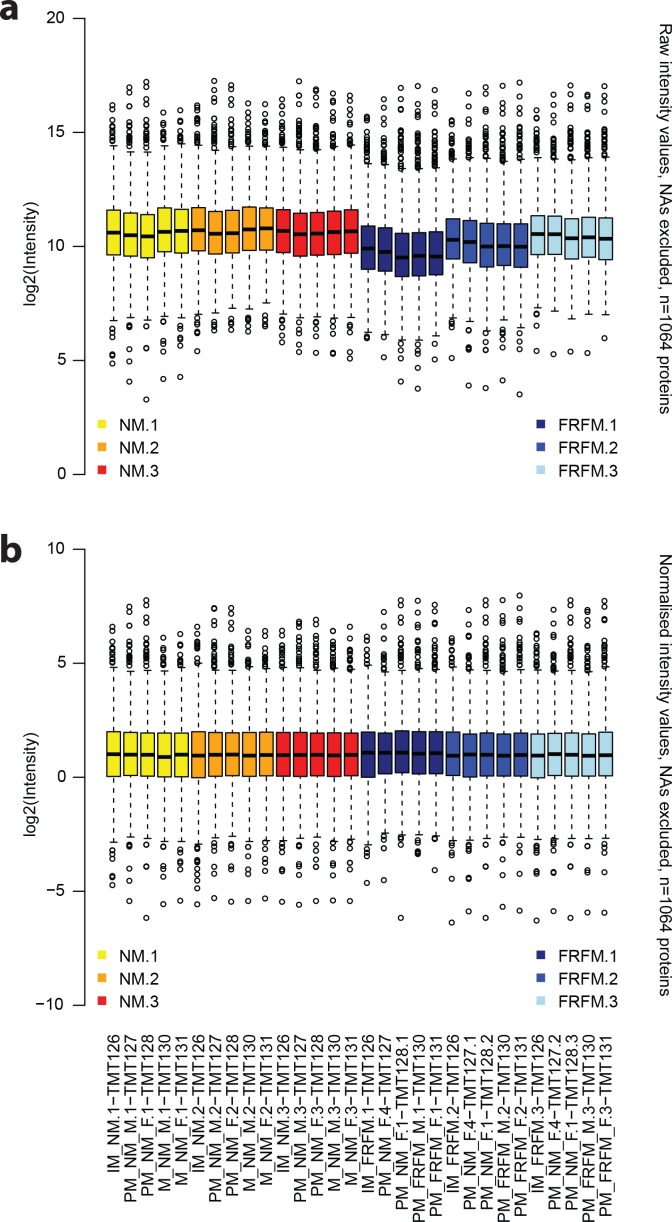
The normalisation procedure applied to the raw protein abundance values leads to evenly spread and centred abundance profiles.(a) Raw intensity values for each of the proteome measurements, excluding missing data. (b) corresponding abundance values after normalisation. Annotations on the x axis in (b) also correspond to the respective columns in (a). Yellow: NM samples BR1, orange: NM samples BR2, red: NM samples BR3, dark blue: FRFM samples BR1, blue: FRFM samples BR2, light blue: FRFM samples BR3. Suffices TMT_XYZ denote the label, used for labelling the respective sample, that is TMT126 is labelled with a tandem mass tag with the reporter mass of 126 Da.